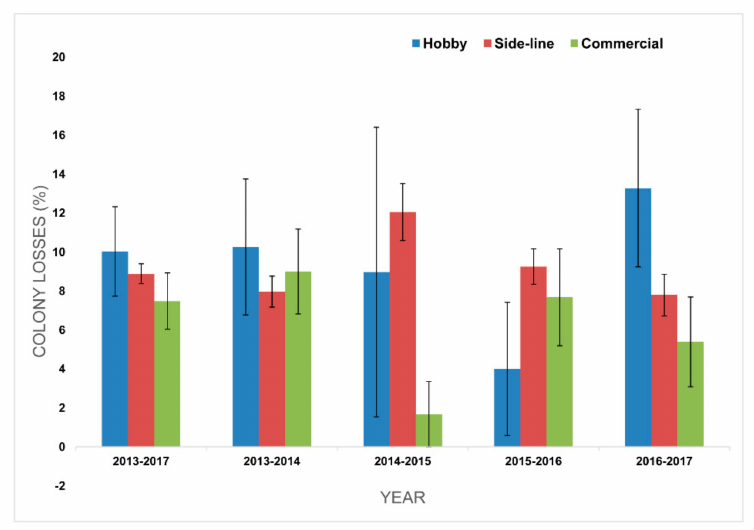
Figure 3. Comparison of colony winter losses by di ff erent type of apiaries for the years 2013–2017, 2013–2014, 2014–2015, 2015–2016 and 2016–2017. Means and 95% confidence intervals are